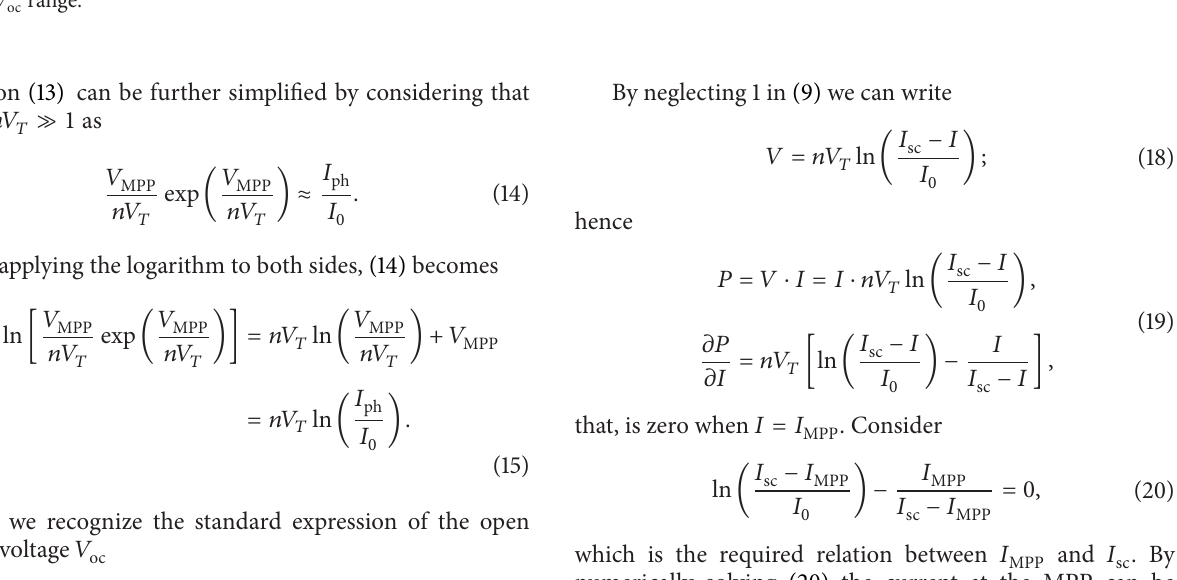
with respect to the 𝑉 . The grey area highlights the MPP oc